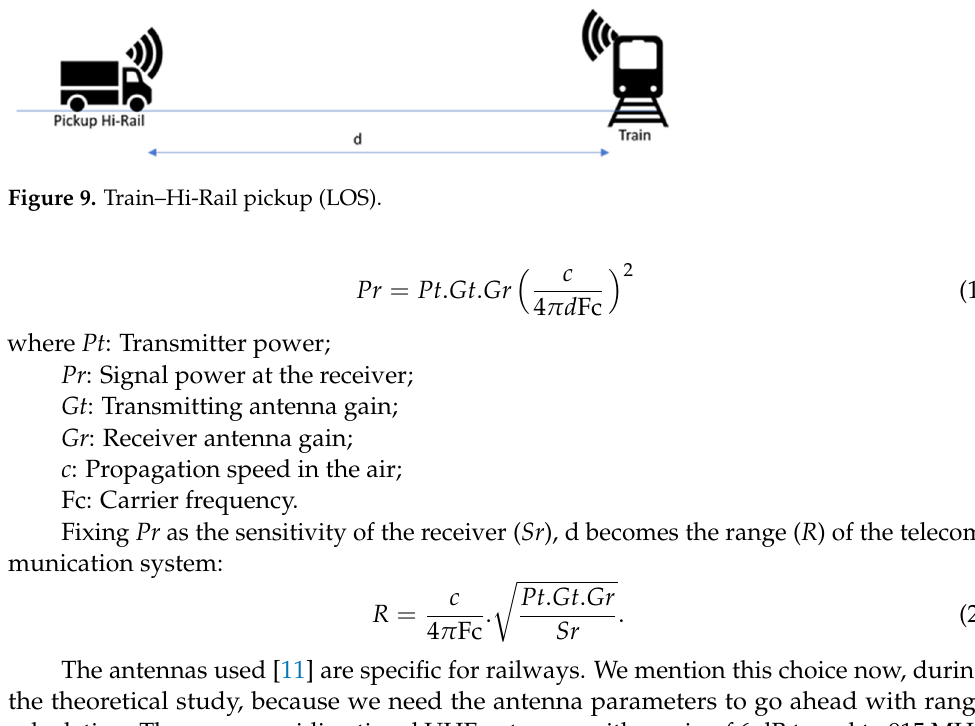
Figure 9. Train–Hi-Rail pickup (LOS).